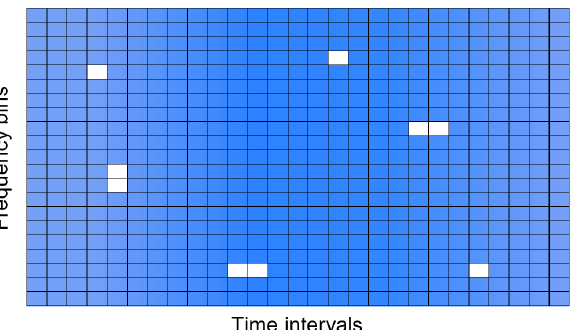
Figure 7. Example of the dynamic determination of the frequency bins to be removed by the adaptive filter (one FFT). Measured power spectral density (PSD) samples are shown.